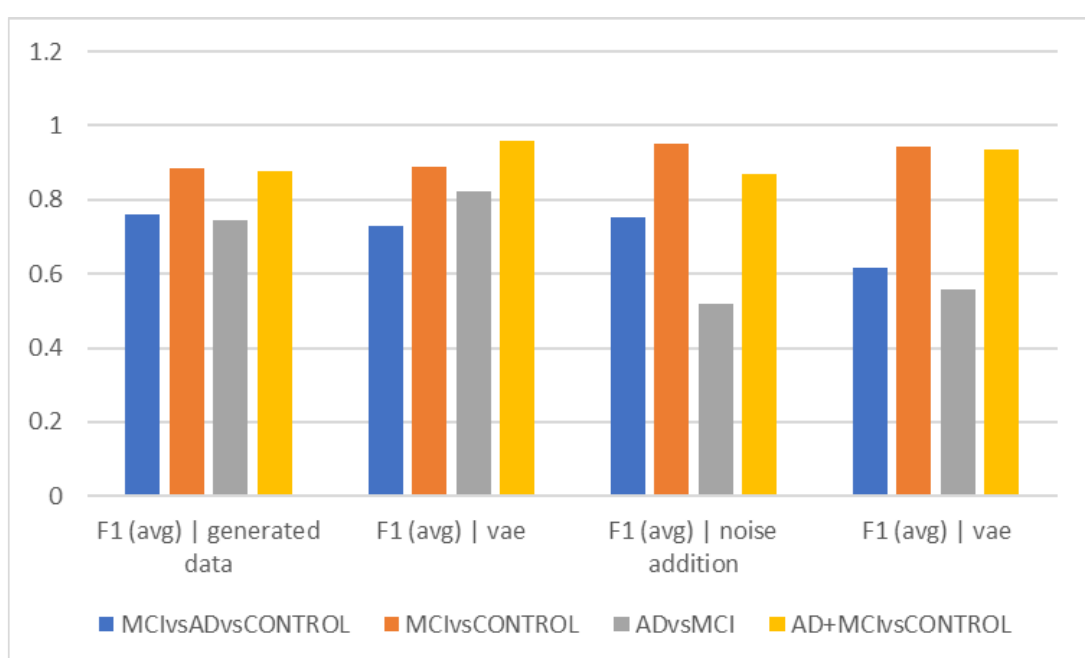
Figure 4. Comparison of results for a period of 10 s (accuracy).